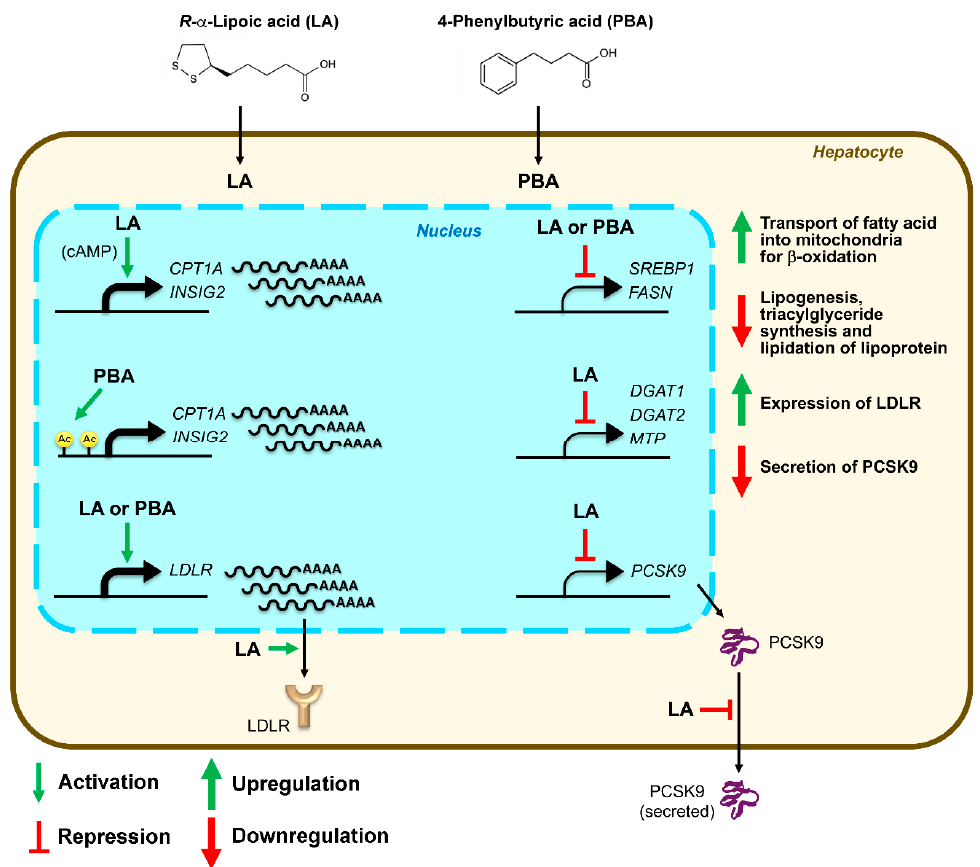
Figure 7. Schematic diagram summarizing the molecular effects of LA and PBA, and expected consequences on lipid metabolism in hepatocytes.